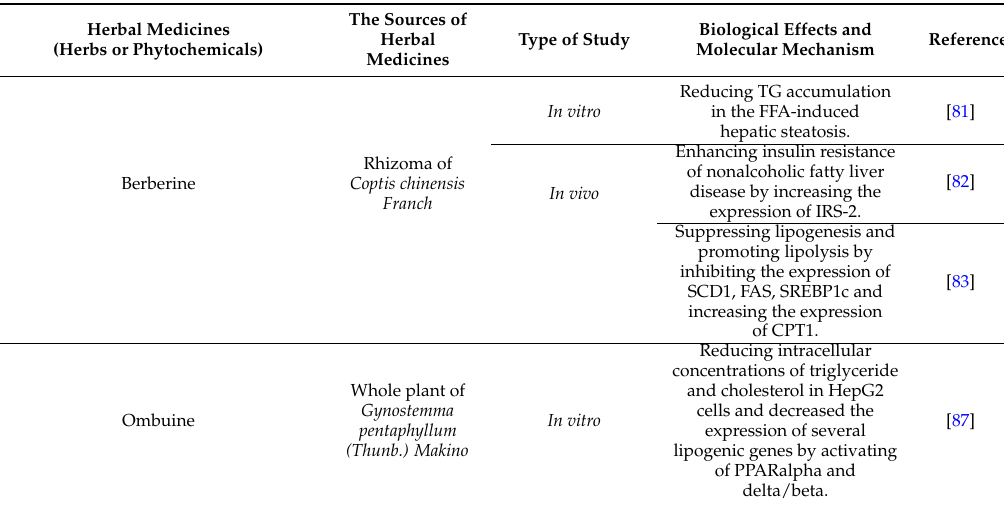
Table 2. Herbs and phytochemicals in fatty liver disease